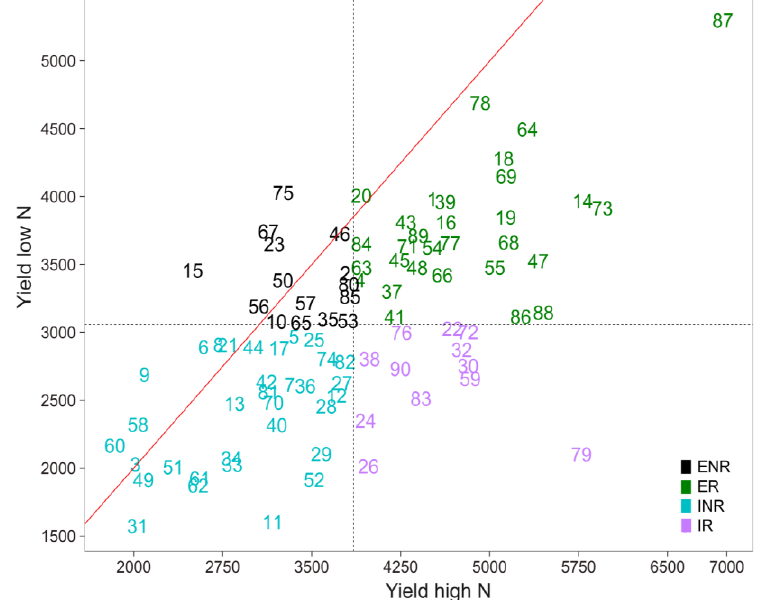
Figure 4. Performance in relation to the efficiency use nitrogen and the response to nitrogen fertilization in the 90 popcorn hybrids evaluated in Itaocara, RJ. ER: efficient and responsive; ENR: efficient and nonresponsive; IR: inefficient and responsive; and INR: inefficient and nonresponsive.